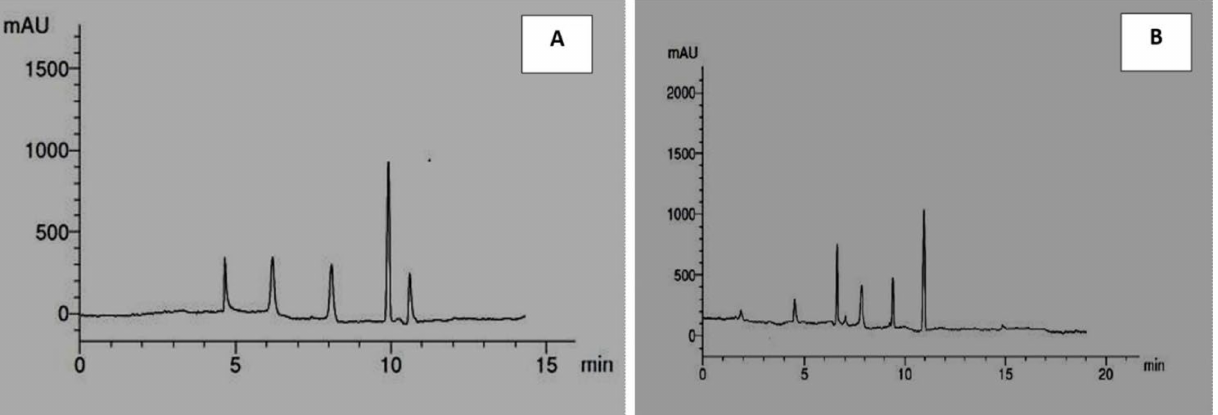
Figure 1. HPLC chromatographic profiles of phenolic acids ( A ) and flavonoids ( B ) in methanolic extract of Solenostemma argel